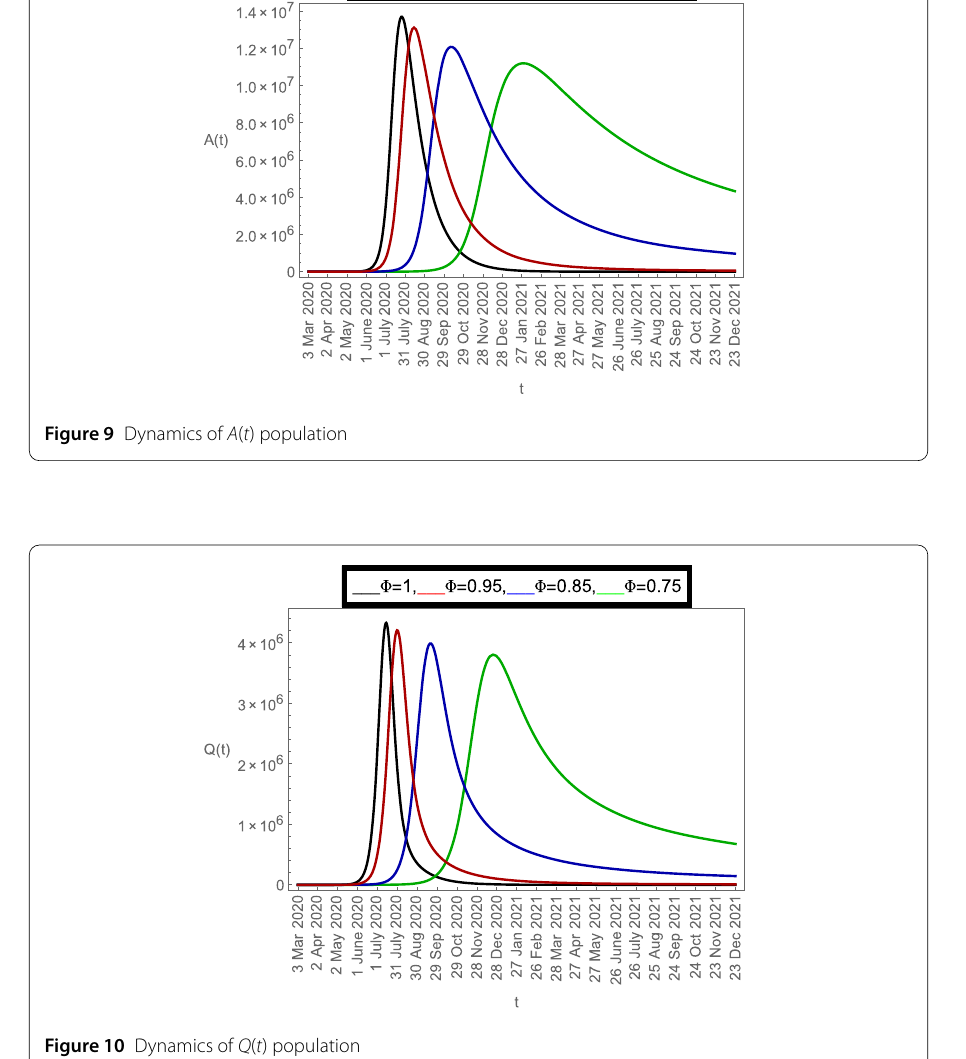
2020 at Φ = 0.85, and around 30 Dec 2020 at Φ = 0.75. Finally, Fig. 12 shows the nature of recovered individuals R ( t ) versus given time